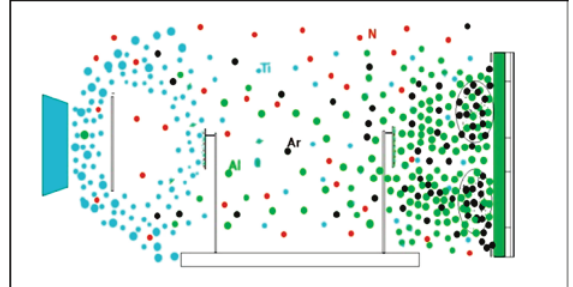
fig. 8. Schematic diagram of obtaining conglomerate deposition